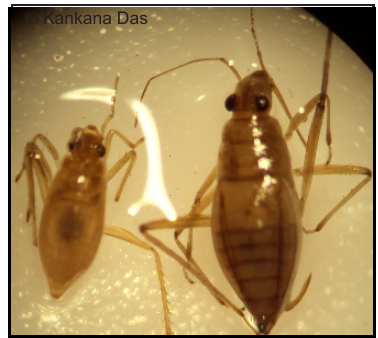
Image 15. Mesovelia vittigera (male and female)